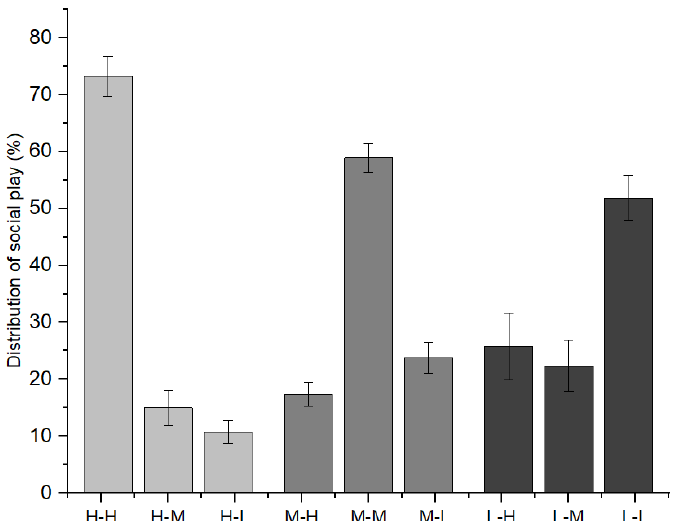
Figure 3. The relationships between playmates and the mothers’ social rank categories among im- mature individuals (H: high-ranking mother, M: middle-ranking mother, L: low-ranking mother).